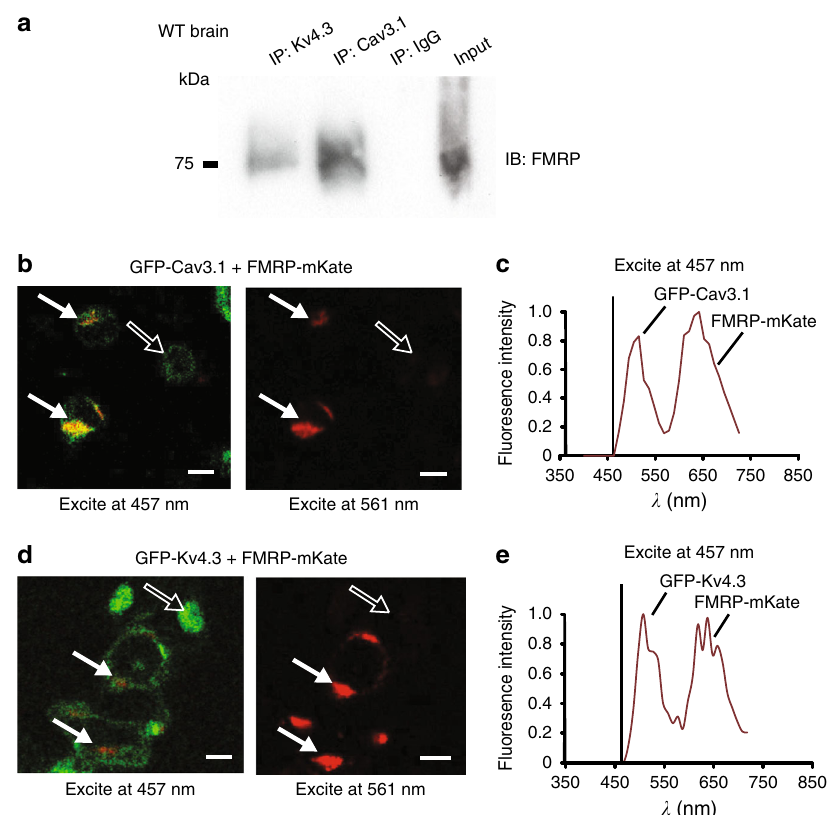
Fig. 2 Cav3.1 and Kv4.3 channels co-associate with FMRP. a Co-immunoprecipitation (coIP) of FMRP with Cav3.1 or Kv4.3 from whole brain lysates of WT mice. Immunoprecipitation (IP) was conducted using rabbit anti-Cav3.1 and rabbit anti-Kv4.3 antibodies and rabbit IgG (as control), and immunoblotting using a mouse anti-FMRP N-terminus antibody. All coIP experiments were derived from at least three different experiments. b , c tsA-201 cells coexpressing GFP-Cav3.1 and FMRP-mKate as a donor – acceptor pair exhibit FRET upon excitation of GFP at 457 nm ( b solid arrows). A representative example of peak fl uorescent emissions for both GFP and mKate upon excitation at 457 nm is shown in ( c ). No dual emissions are detected in cells expressing only GFP-Cav3.1 (open arrows) or in cells expressing both GFP-Cav3.1 and FMRP-mKate when excited at 561 nm (solid arrows) ( b ). d , e tsA- 201 cells coexpressing GFP-Kv4.3 and FMRP-mKate exhibit FRET upon excitation of GFP at 457 nm (solid arrows) that is absent in cells expressing only GFP-Cav3.1 (open arrows) ( d ). A representative example of peak fl uorescent emissions for both GFP and mKate upon excitation at 457 nm for cells is shown in ( e ). Scale bars in ( b , d ), 10 μ m. All FRET experiments were derived from three different experiments with at least three different dishes of cells. Source data are provided as a Source Data fi